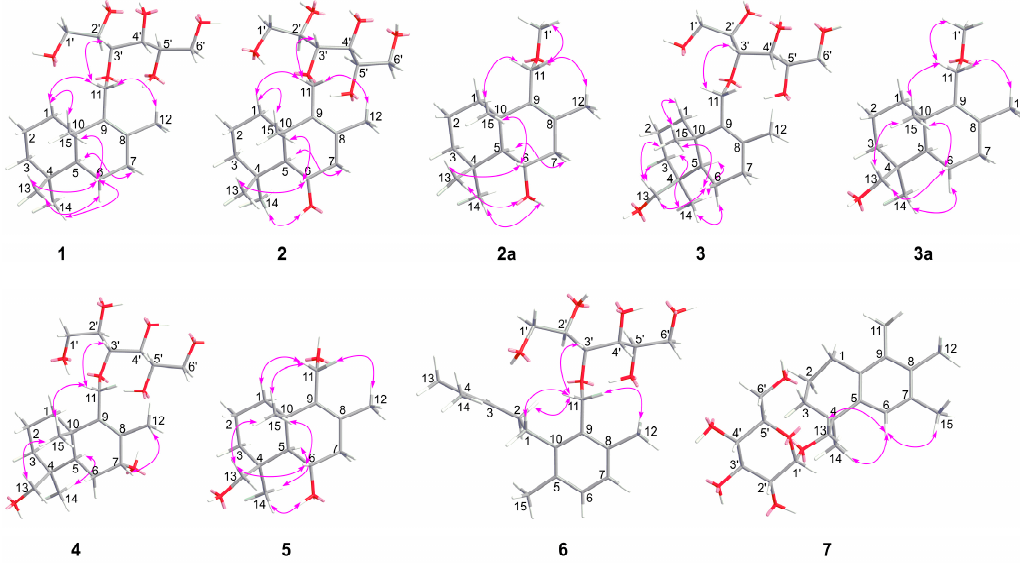
Figure 3. Selected NOE correlations for 1 – 7.